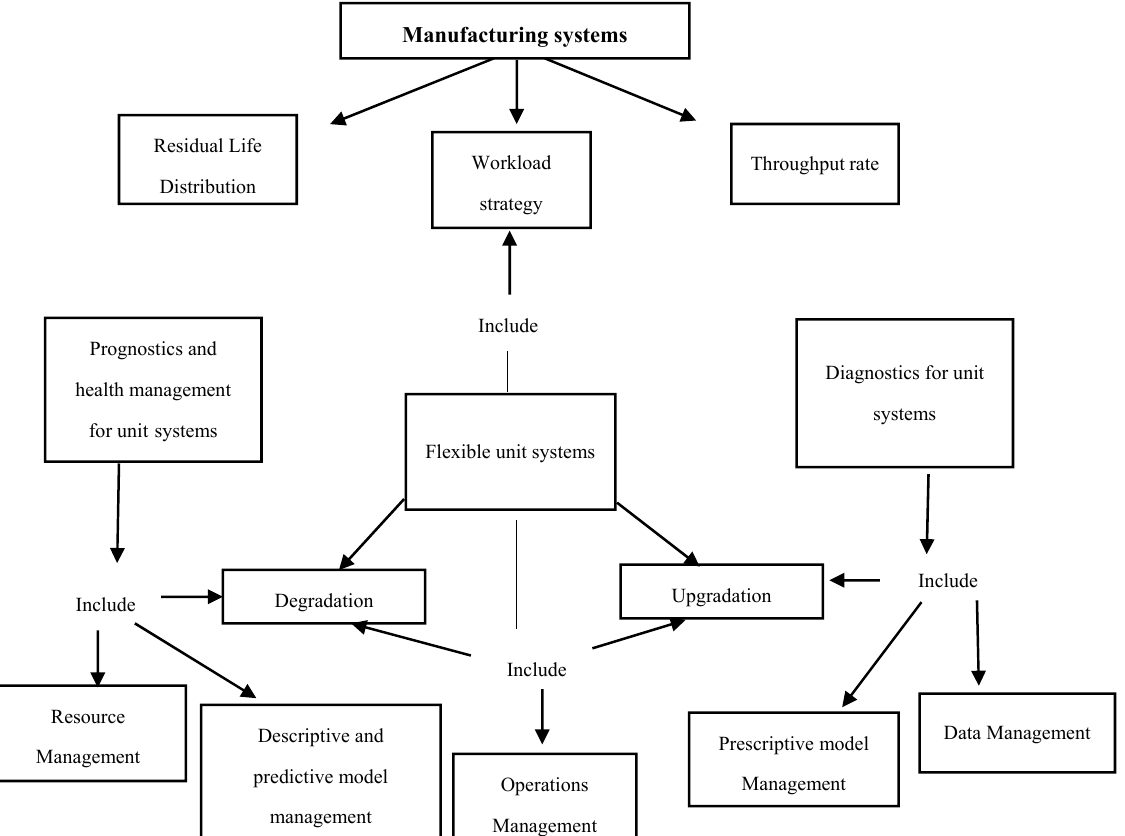
Figure 1. Framework addressing the topics affecting flexible unit systems (FUS).